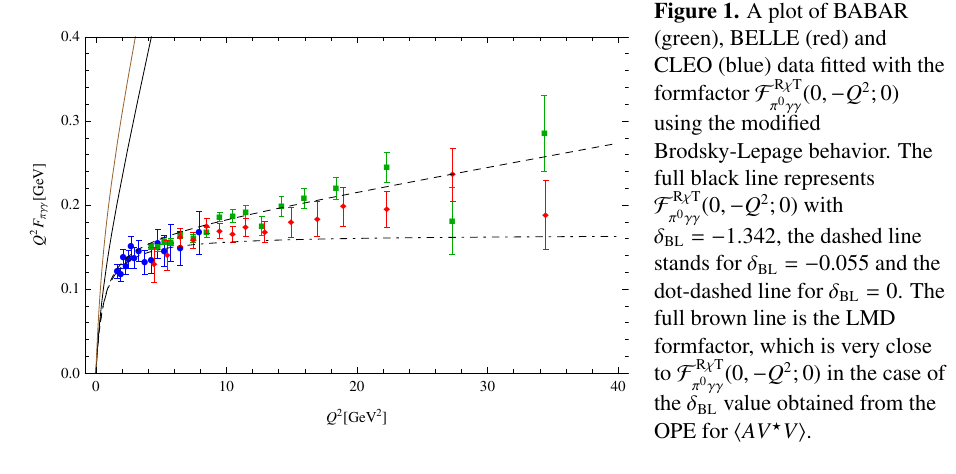
Figure 1. A plot of BABAR (green), BELLE (red) and CLEO (blue) data fitted with the formfactor F R χ T (0 , − Q 2 ;0) π 0 γγ using the modified Brodsky-Lepage behavior.